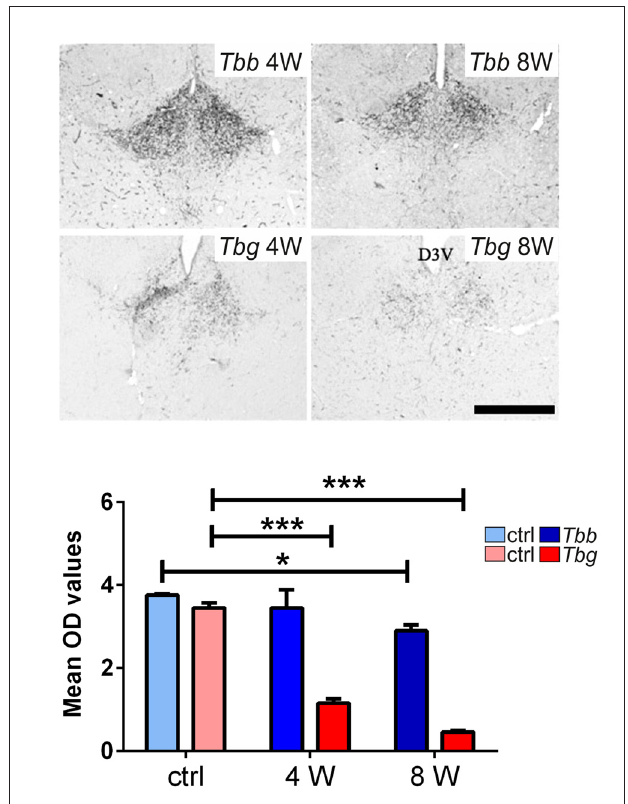
FIGURE 7 | Top: images of the paraventricular thalamic nucleus (PVT) of Mastomys natalensis showing OX-A-immunoreactive fibers at 4 weeks (W) and 8 W after infection with Trypanosoma brucei brucei ( Tbb ) or Trypanosoma brucei gambiense ( Tbg ). Note the marked decrease of PVT orexinergic innervation, especially after T. b. gambiense infection (see also Figure 6 ). Scale bar: 250 µ m. Bottom: bar graphs of the quantitative densitometric evaluation (OD, optical density) of OX-A immunosignal in PVT of control (ctrl) and infected animals. ∗ P < 0.05; ∗∗∗ P <